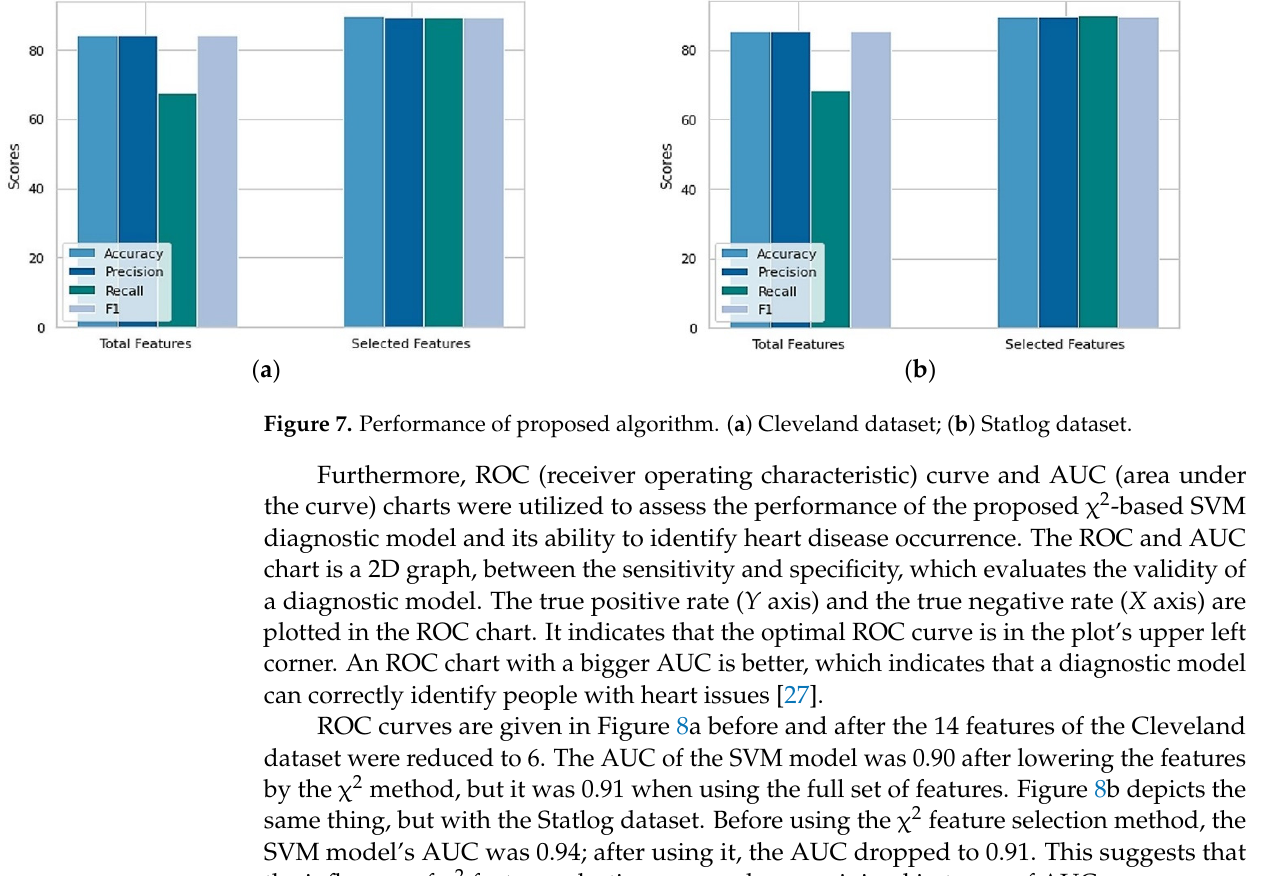
Figure 7. Performance of proposed algorithm. ( a ) Cleveland dataset; ( b ) Statlog dataset.